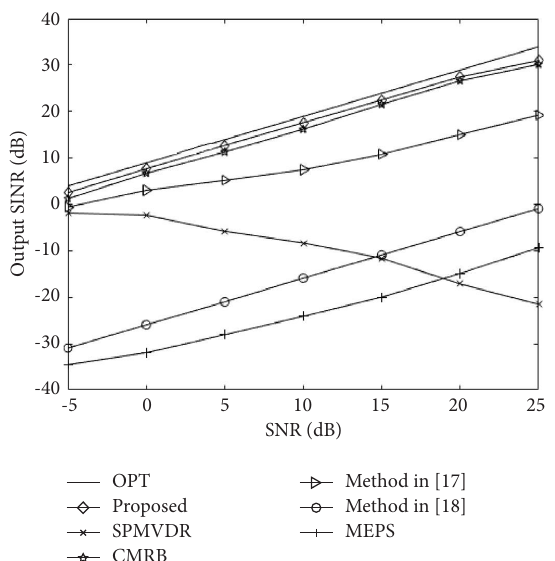
Figure 4: Output SINR versus SNR with a parameter error of the desired signal.